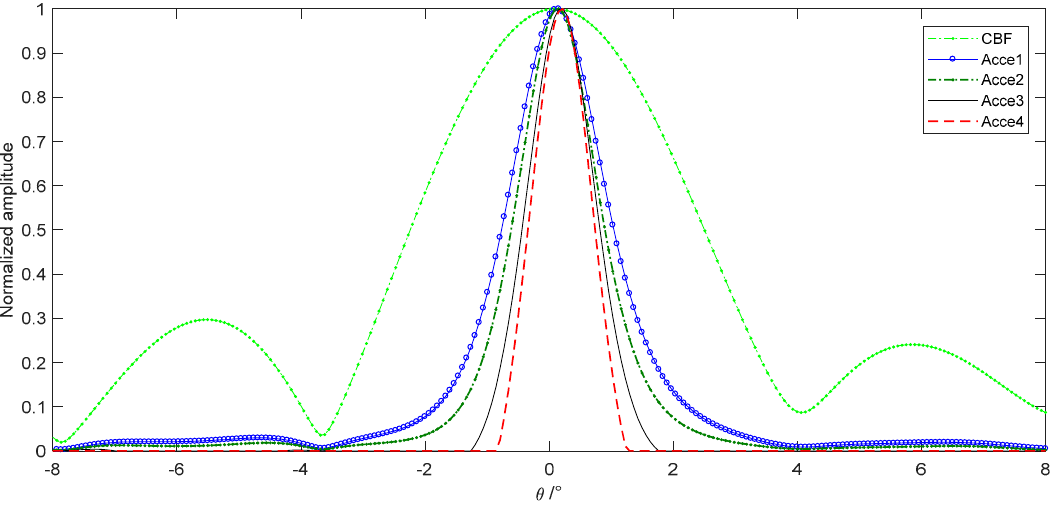
Figure 14. Imaging performance of different acceleration methods.